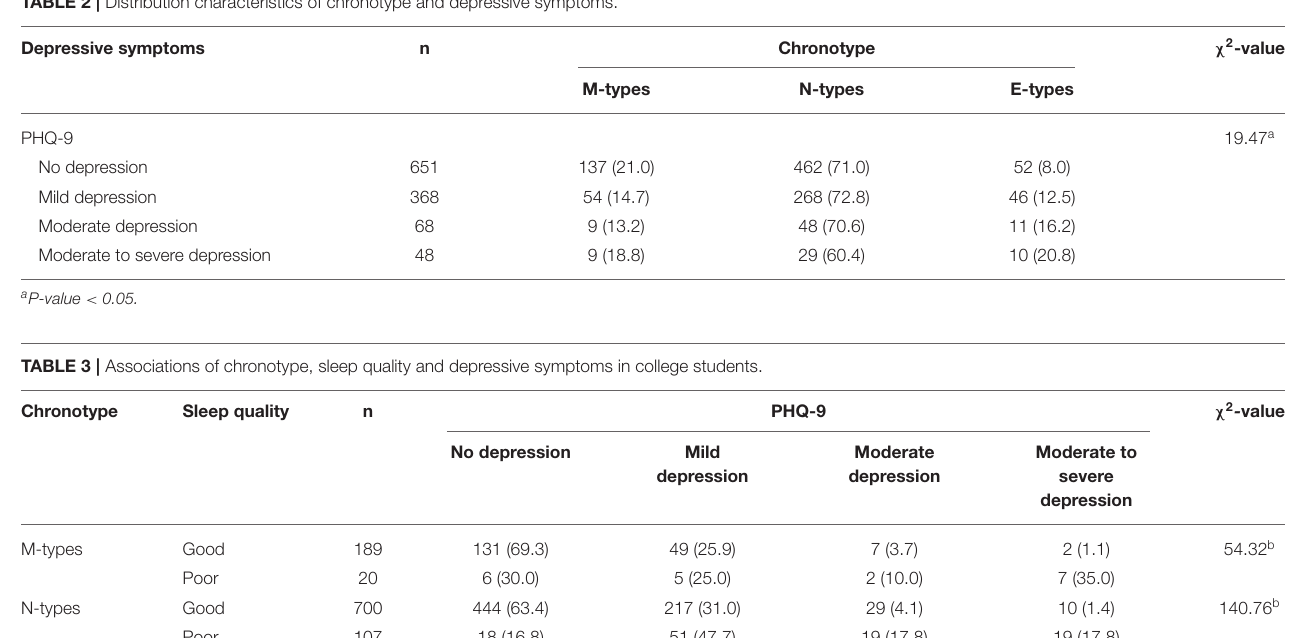
TABLE 2 | Distribution characteristics of chronotype and depressive symptoms.